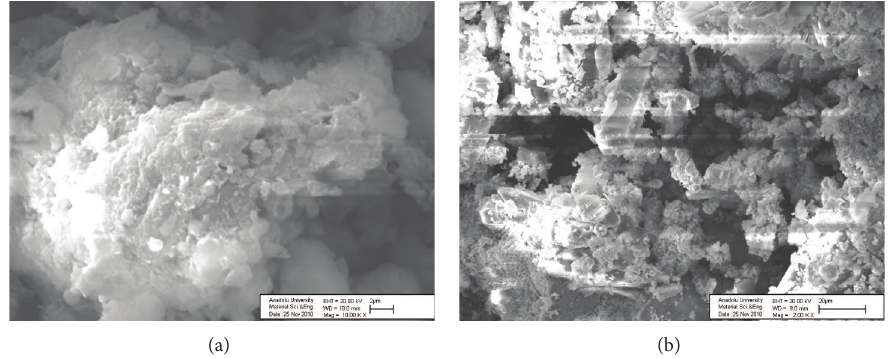
Figure 1: SEM micrographs of the montmorillonite (a) and industrial waste (b) samples.